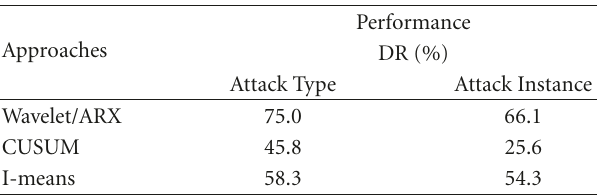
Table 14: Detection rate for all three approaches in terms of attack type and